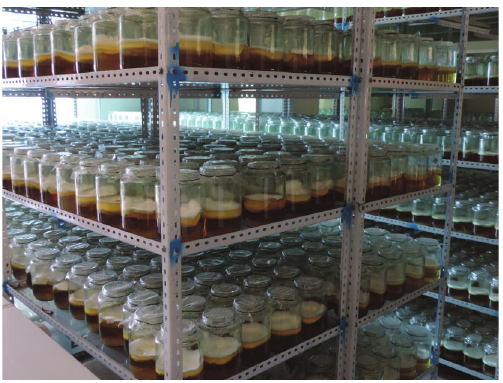
Figure 8: Batch culture for cordycepin production under optimized culture conditions by static liquid culture using C. militaris (strain